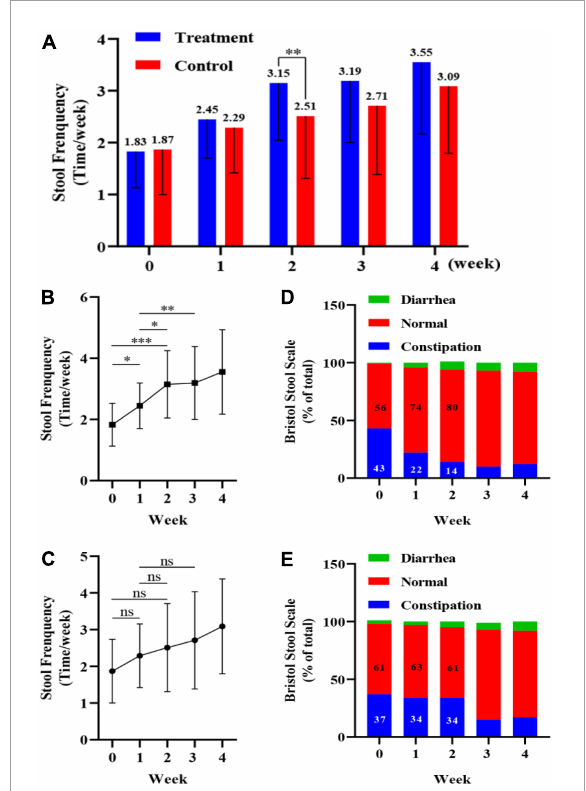
FIGURE3 Impact of a probiotic chewable tablet on stool habits. (A) Stool frequency during the observation period and after 4 weeks of intervention. ∗∗ p < 0.01, Student’s t -test. (B) Change in stool frequency during the observation period and intervention period for children in the probiotic (treatment) group. ∗ p < 0.05, ∗∗ p < 0.01, ∗∗∗ p < 0.001, Tukey’s post-hoc test. (C) Change in stool frequency during the observation period and dry period in children in the placebo (control) group. ns p > 0.05, Tukey’s post-hoc test. (D) Percentage of stool type, via the Bristol stool scale (BSS), in the treatment group during the observation and intervention periods. (E) Percentage of stool type, via the BSS, in the control group during the observation and